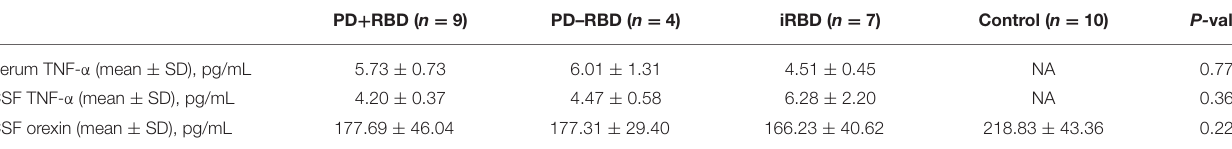
TABLE 2 | Biomarkers including tumor necrosis factor-alpha (TNF- α ) in serum and cerebrospinal fluid (CSF), orexin in cerebrospinal fluid in the three groups.